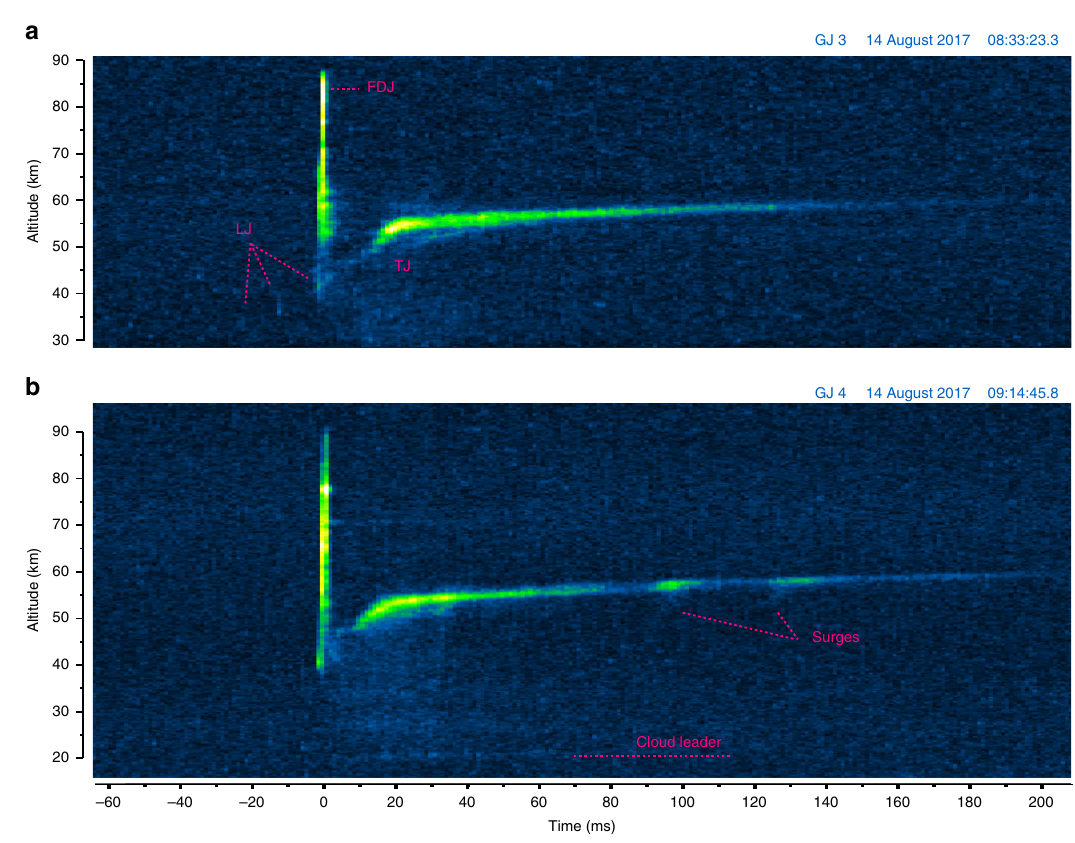
Fig. 4 The evolution of brightness with altitude in gigantic jets 3 and 4. Time-altitude-luminosity graphs derived from high speed video images of the jet events with a temporal resolution of 1.11 ms. The graphs are scaled such that equal slopes correspond to the same speed across the events. a GJ 3 with the Leading, Fully Developed, and Trailing Jet stages indicated. b GJ 4. Note that the section below 30 km in GJ 3 was not within the view of the high speed